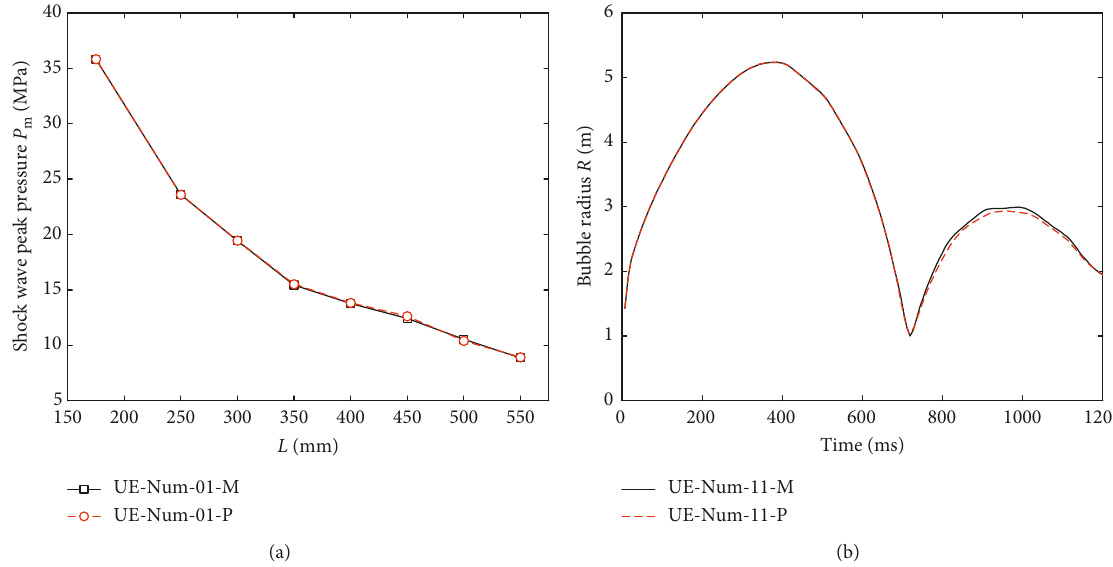
Figure 4: (a) Curve of the shock wave peak pressure P m with standoff distance L under model conditions. (b) Curve of bubble radius R with time under prototype conditions.